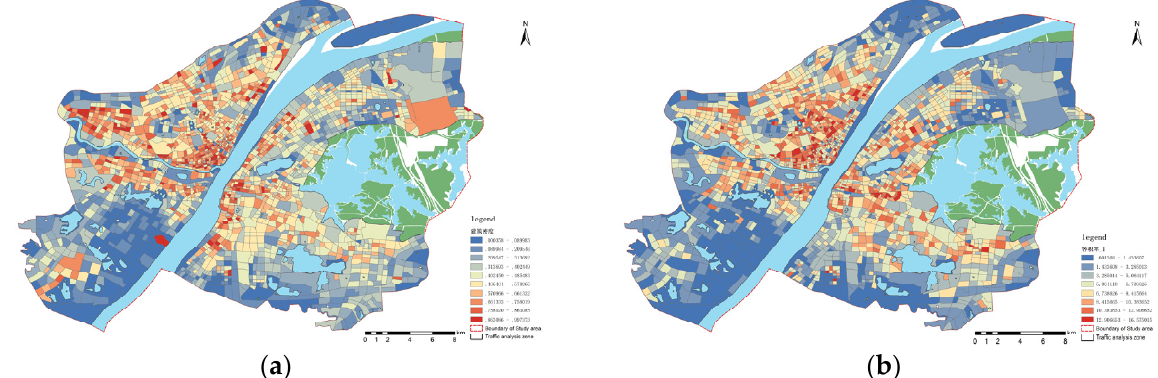
Figure 12. Block development intensity. ( a ) Building density; ( b ) floor area